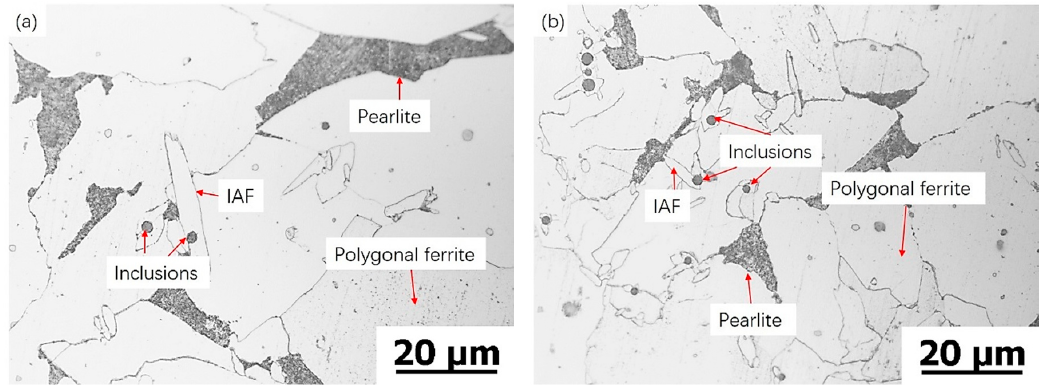
Figure 2. Ingots microstructure of testing steel: ( a ) with V; and ( b ) with Nb.